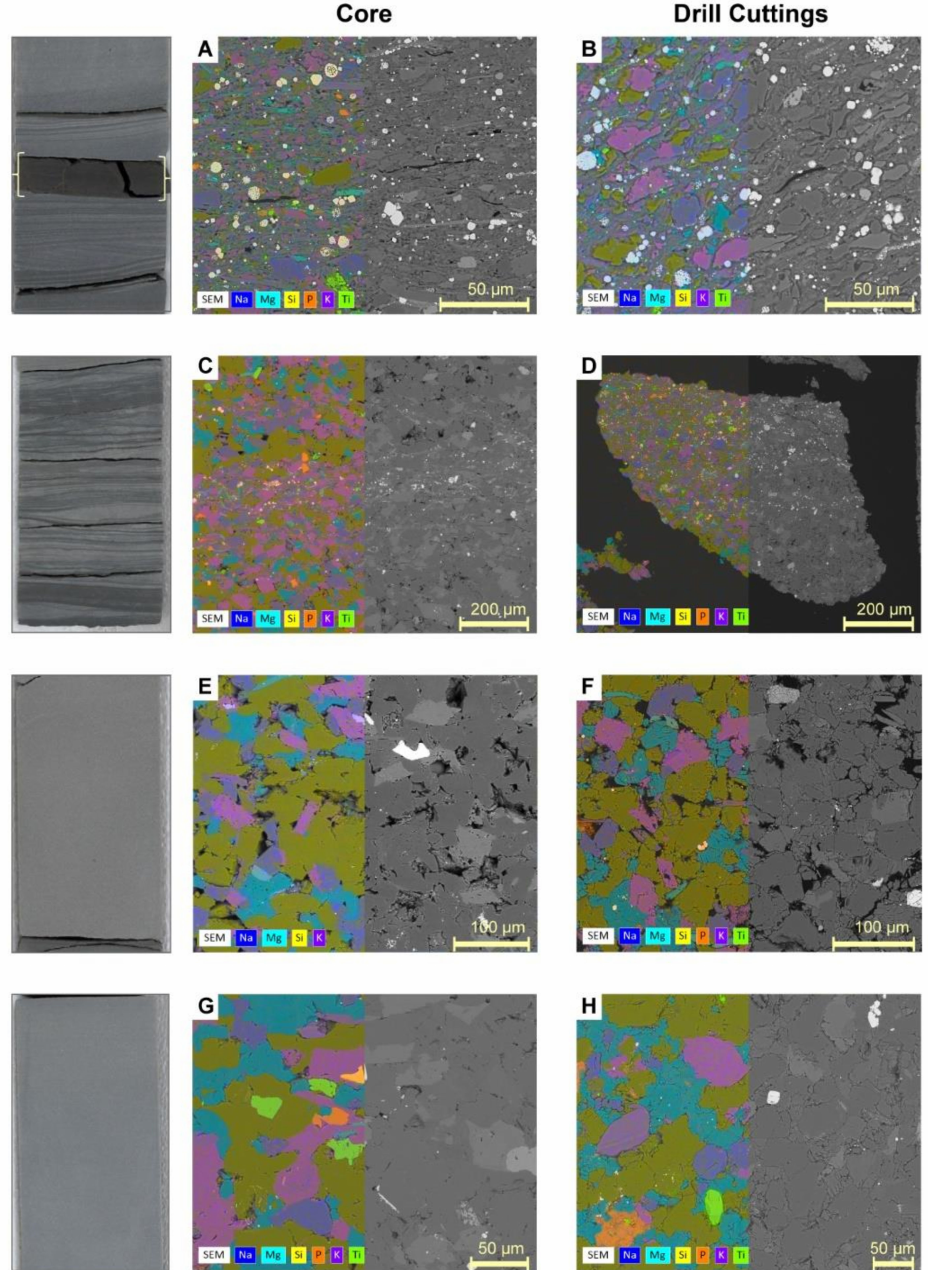
Figure 5. SEM-BS-EDX images comparing four identifiable rock types in the drill cuttings ( B , D , F , H ) and their associated core-facies ( A , C , E , G ). Core samples shown in this figure were collected from the targeted Montney Interval. ( A , B ) Organic-rich mudstone. ( C , D ) Heterolithic siltstone. ( E , F ) Porous siltstone. ( G , H ) Well-cemented siltstone. The diameter of the shown core is 8 cm (left